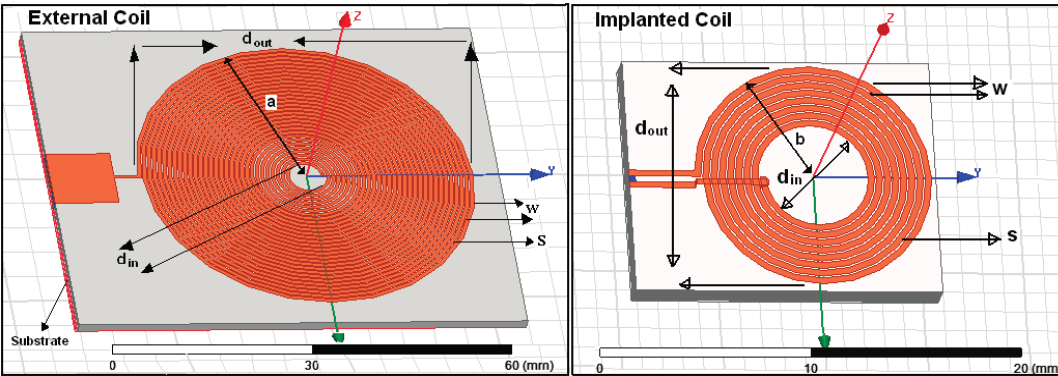
Figure 3. Coil geometries simulated by HFSS